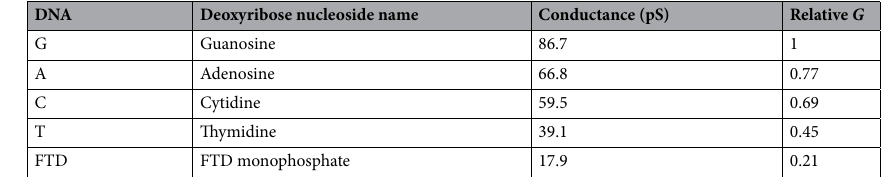
Table 2. Single-molecule conductance and relative single-molecule conductance of deoxyribonucleosides and trifluridine (FTD). Single-molecule conductance was obtained from the peak of conductance histograms as previously described 15,17